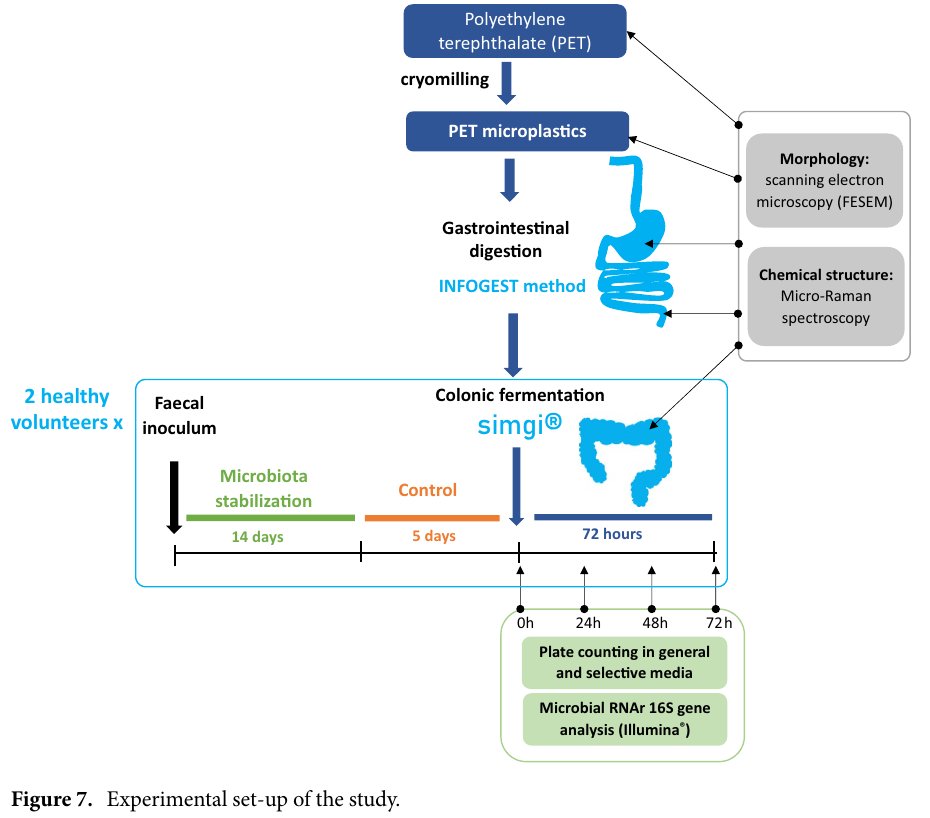
Figure 7. Experimental set-up of the